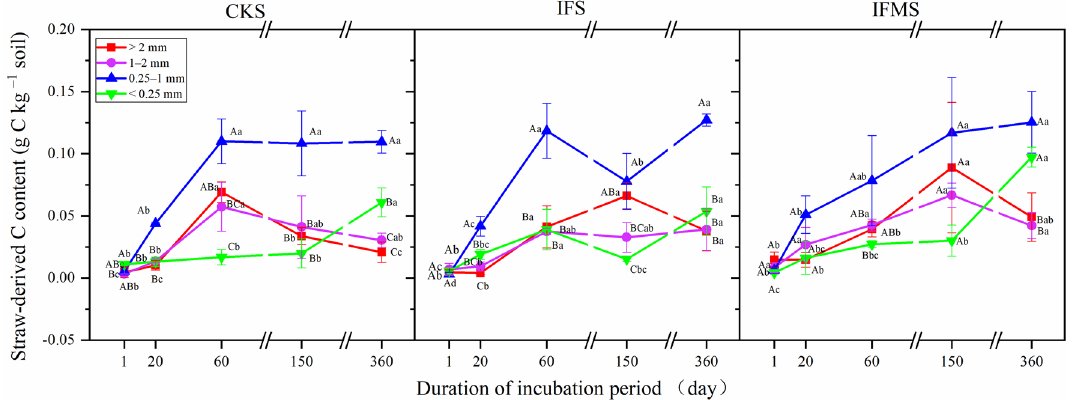
Figure 3. The straw-derived C contents in aggregates under different fertilizer management strategies. Note : Treatments including CKS (no fertilization control + straw), IFS (inorganic fertilizer + straw), IFMS (inorganic fertilizer plus manure + straw). Vertical bars represent the standard error of the mean significant variations (SEM; n = 3). Values followed by different letters (uppercase among various aggregate sizes and lowercase among various incubation periods) mean significant variations ( P < 0.05) in straw-derived C contents.